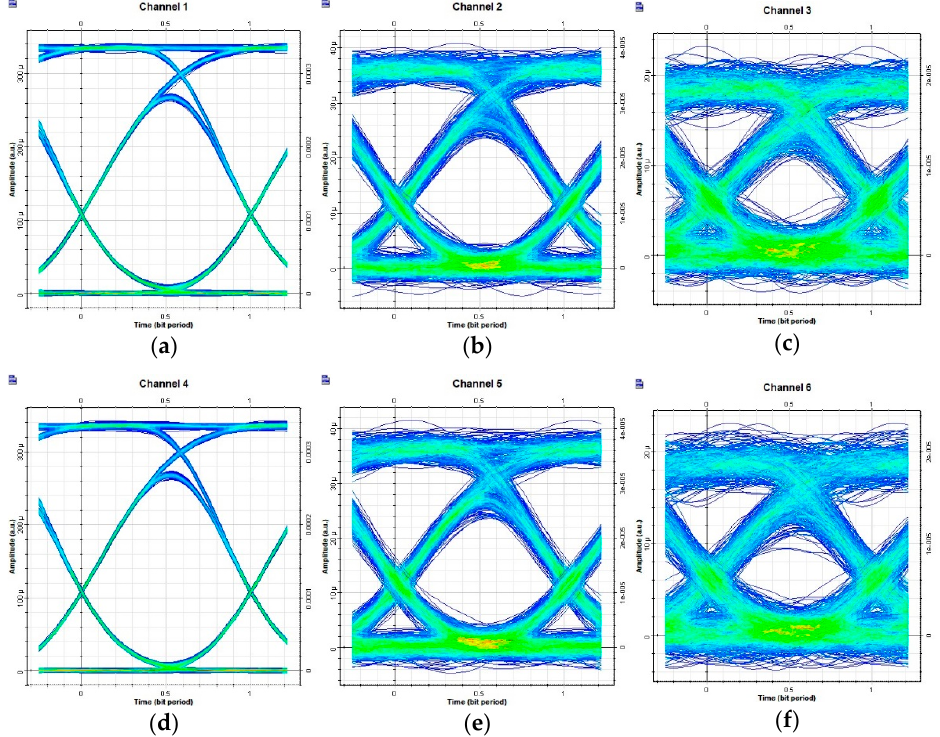
Figure 6. Log (BER) against FSO link for OAM/OCDMA-FSO system under ( a ) LF, ( b ) MF, and ( c ) HF.